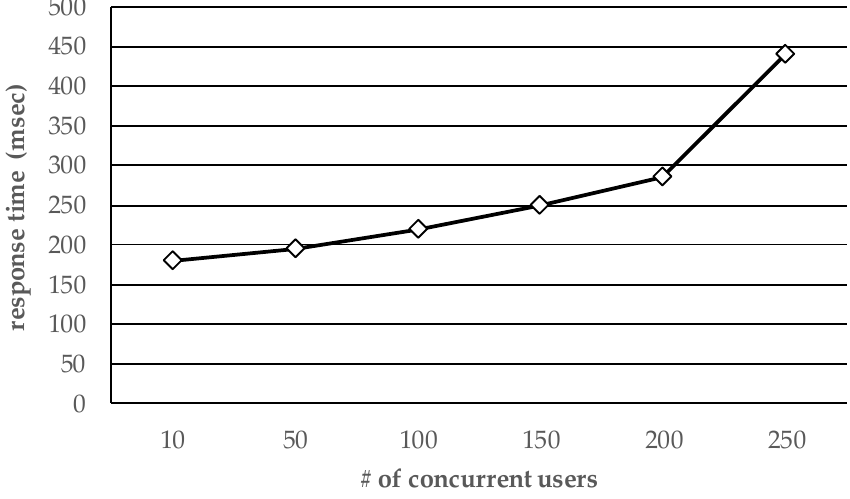
Figure 9. Trajectory proposals formulation time for varying degrees of concurrency.